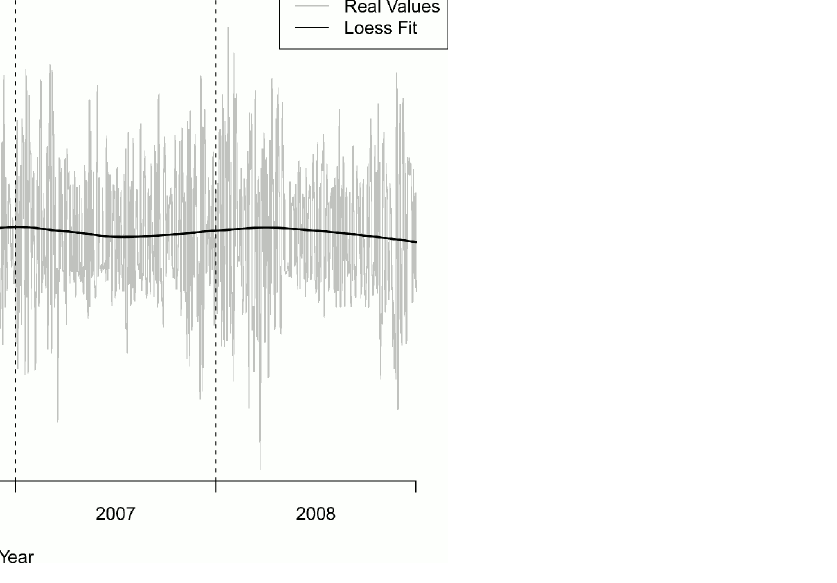
Fig 1. Change in air pressure over time. Station Munich-City.